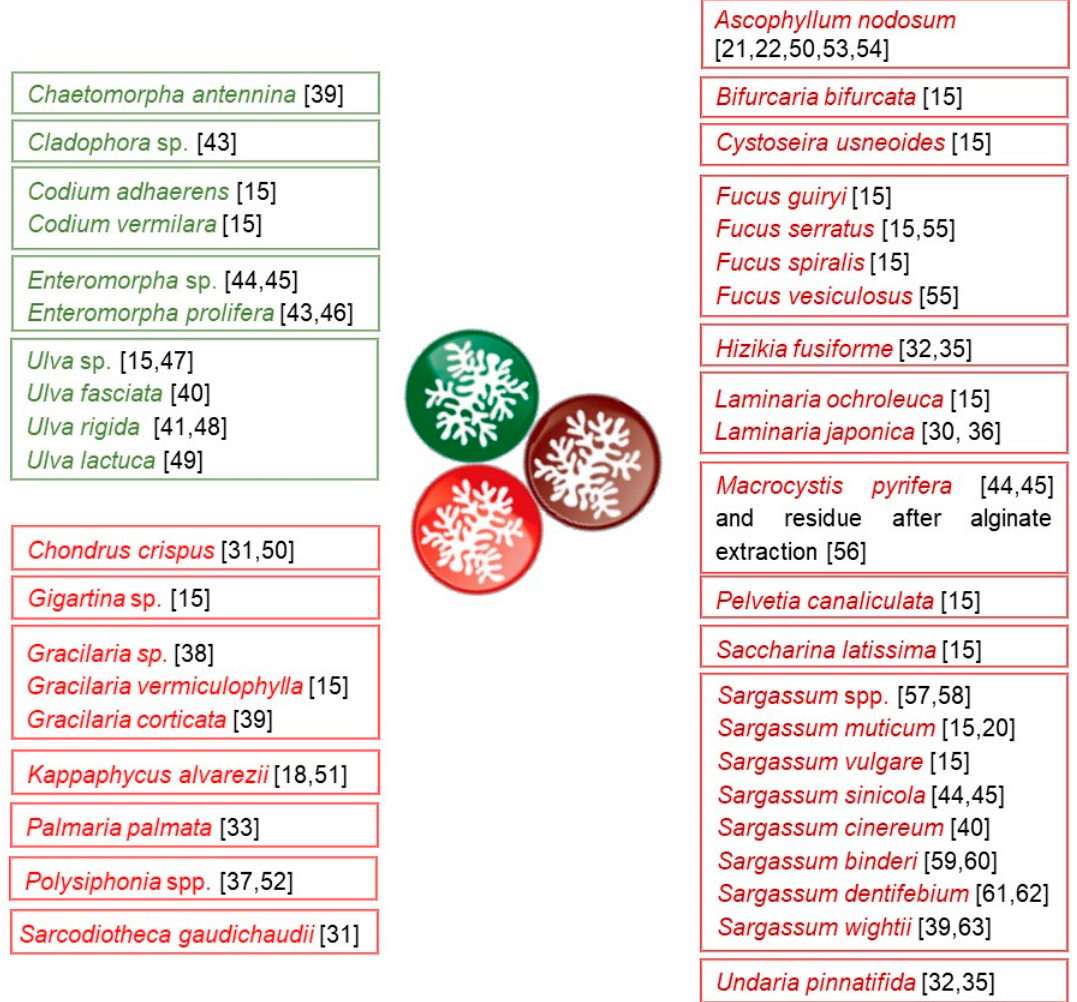
Figure 1. Examples of seaweeds used in poultry feeding